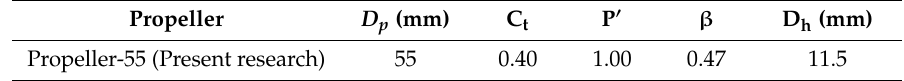
Table 2. Propeller characteristics.